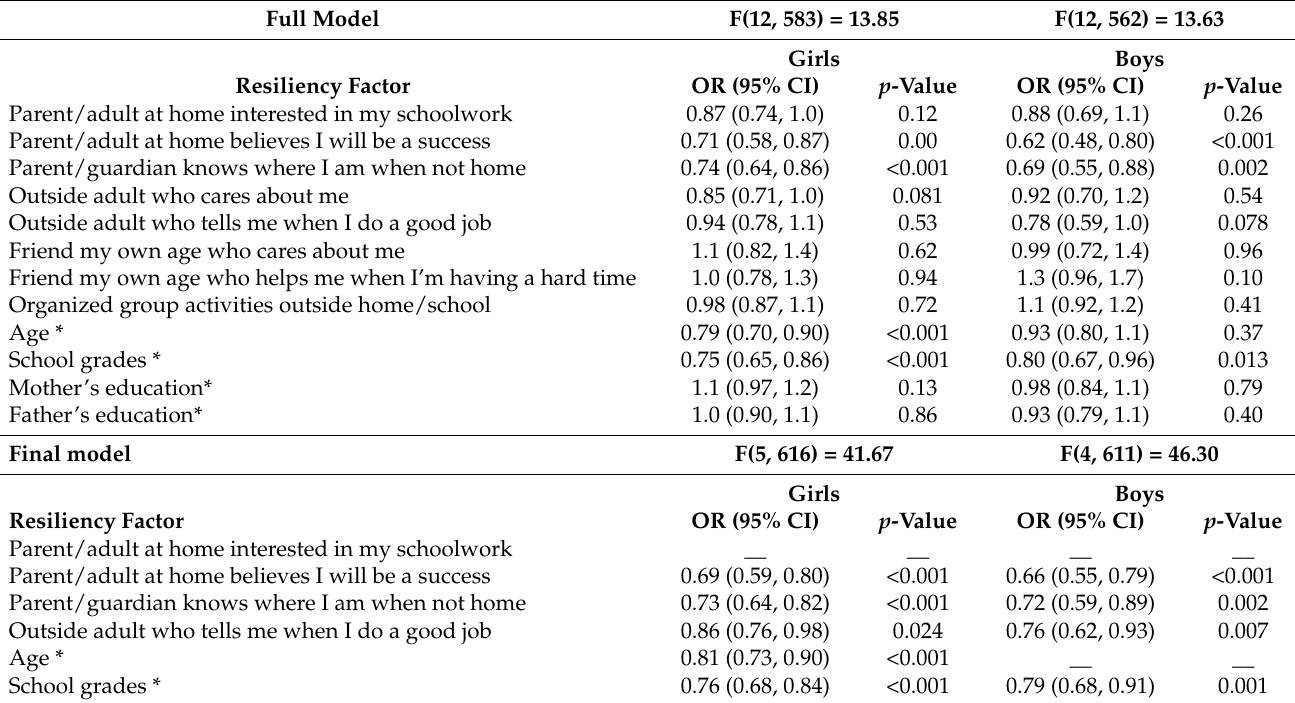
Table 3. Multivariable models (full model and final model) showing factors associated with lower probability of past-year suicide attempts among Hispanic schoolchildren, by sex, 2019 NM